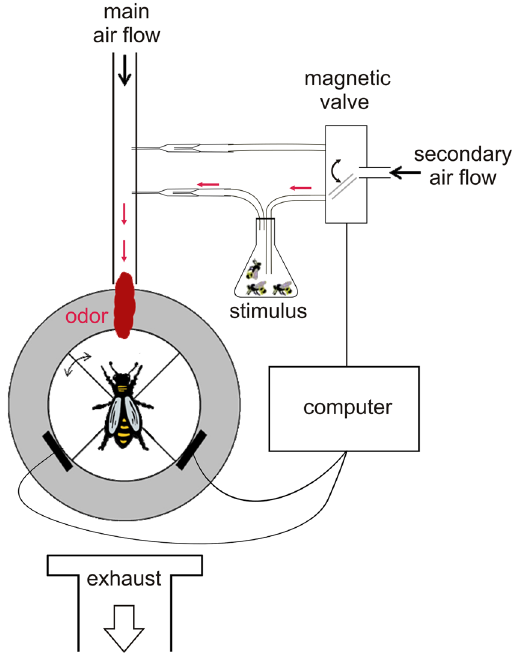
Figure 1. Walking simulator setup. A tethered honeybee queen or worker is allowed to freely walk on an air-supported ball (in white). The bee can easily turn the ball under herself. Ball displacement is recorded via two computer-mouse sensors (black bars close to the ball), which allow reconstructing the bee’s walking path. Odour stimulation is provided via a main, constant, air-stream directed to the bee. Odours are quickly removed from the setup by an exhaust behind the honeybee. All experiments were conducted in complete darkness. The ball is virtually divided into 4 quadrants, one of which is designated as the odour quadrant. After an accommodation phase of 5 min (‘before’ phase), stimulus control is granted to the bee for 5 min (‘during’ phase): whenever the bee’s virtual heading is in the odour quadrant (as shown on the figure), odour stimulation is activated using the computer-controlled magnetic valves. This allows quantifying, whether the animal preferred receiving odour stimulation or not. Groups of 10 living drones or workers were used as